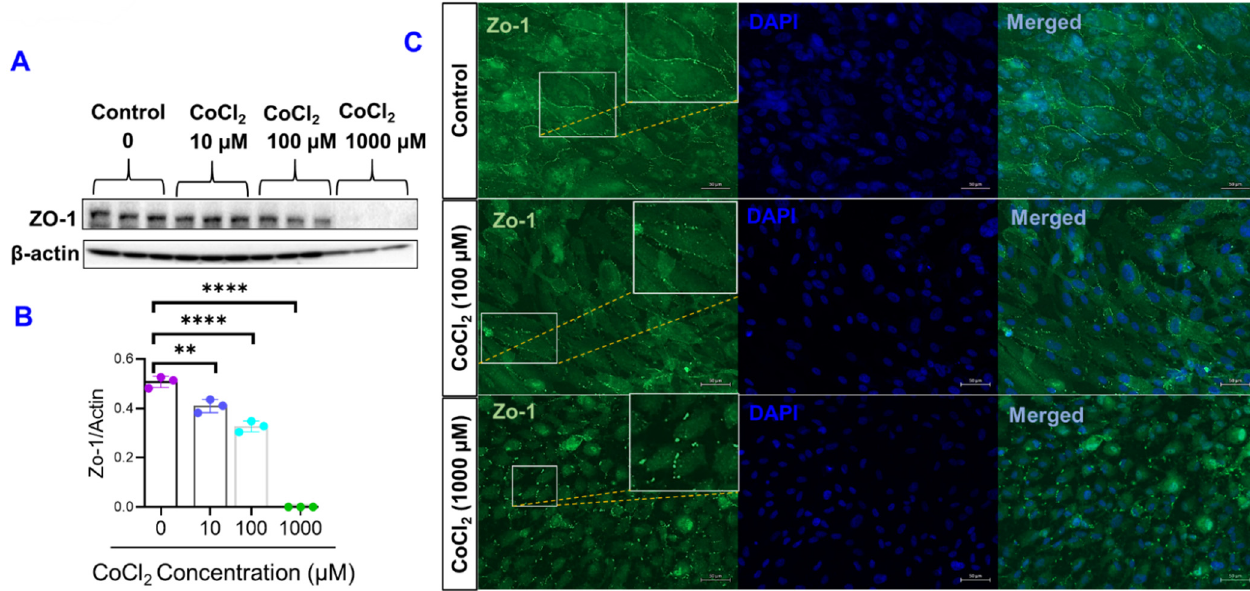
Figure 7. Effects of cytopathic hypoxia on zonula occludens (ZO)-1 expression in ARPE-19 cells. ( A ) Western blot analysis of ZO-1 (198 kD); β -actin (43 kD) was used as the loading control. ( B ) Quantification of densitometric scans of protein bands showing significant decreases in ZO-1 expression in the ARPE-19 cells treated with different concentrations of CoCl 2 for 60 h versus controls. Data shown are the mean ± SD of 3 independent biological replicates ( n = 3/group). p values are ** p ≤ 0.01 and **** p ≤ 0.0001. ( C ) Representative photographs of ZO-1 immunofluorescence (green) in ARPE-19 cells treated with different concentrations of CoCl 2 versus vehicle-treated controls. Enlarged pictures were shown in squares pointing to the punctate pattern alteration in ZO-1 distribution at cellular border of CoCl 2 -treated ARPE-19 cells; scale bar = 100 µm; and the blue staining (DAPI) is a nuclear marker.